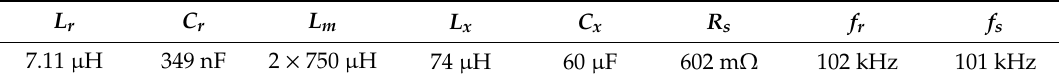
Table 5. Parameters of the